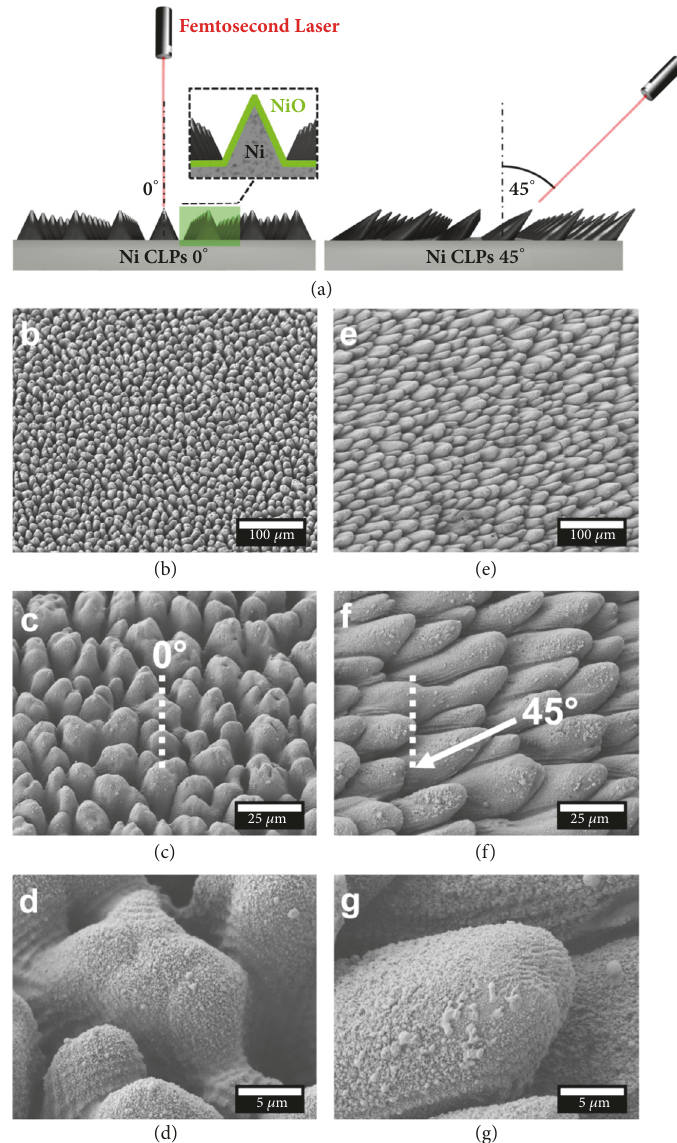
Figure 1: ( a ) Schematic illustrations of the preparation process of the laser-structured Ni electrodes in air. The direction of the formed spikes depends on the incident angle of the laser beam; simultaneously oxidation of the Ni surface occurs. ( b - g ) SEM images of laser-structured Ni electrodes at different magnifications. The irradiation angle of the laser during the structuring was set to 0 ∘ ( b-d ) and 45 ∘ ( e-g ). The SEM images were taken at a sample tilt angle of 25 ∘